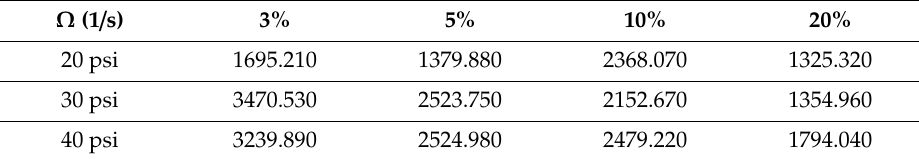
Table 2. Maximum time-averaged vorticity measurements at the vortex generator outlet.